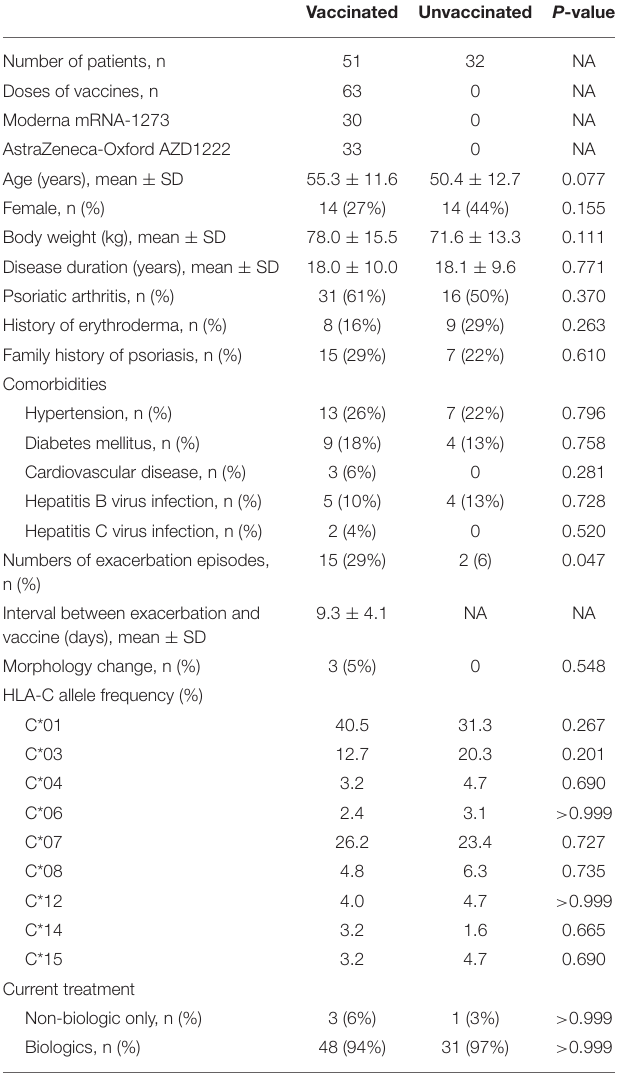
TABLE 1 | Comparison between psoriasis patients vaccinated and unvaccinated against